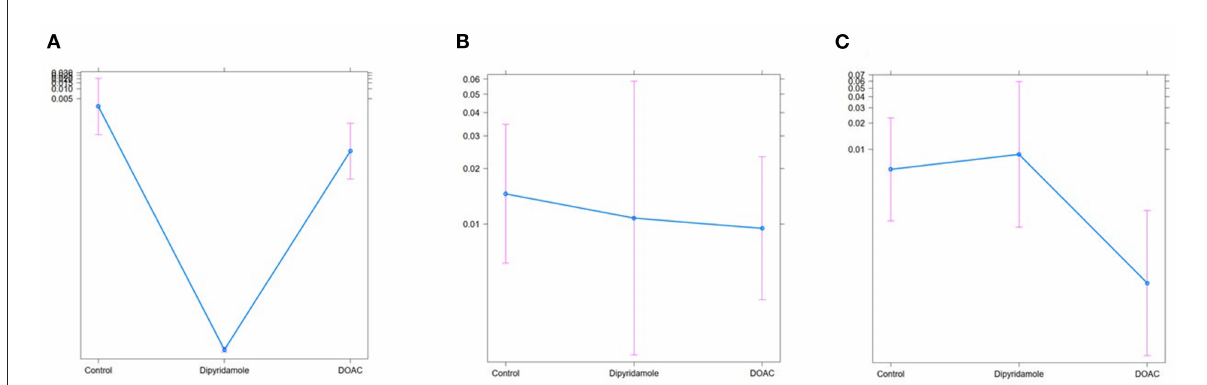
FIGURE8 Treat effect plots of weighted binary logistic regression regarding the predefined study endpoints, depicted are predicted probabilities and 95% CI: (A) pulmonary embolism [predicted probabilities: Ctrl.: 0.03% (95% CI 0.0–0.2) vs. Dipyridamole: < 0.01% (95% CI 0.0–0.1) vs. DOAC: < 0.01% (95% CI 0.0–0.1)], (B) myocardial infarction [predicted probabilities: Ctrl.: 1.5% (95% CI 0.6–3.5) vs. Dipyridamole: 1.1% (95% CI 0.2–5.9) vs. DOAC: 0.8% (95% CI 0.4–2.3)], (C) stroke [predicted probabilities: Ctrl.: 0.6% (95% CI 0.1–2.3) vs. Dipyridamole 0.8% (95% CI 0.1–5.9) vs. DOAC: 0.02% (95% CI